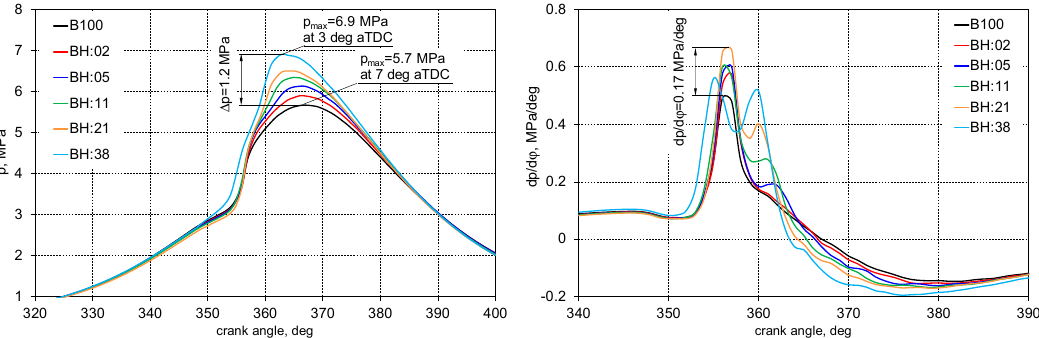
Figure 2. Combustion pressure curve and pressure rise rate for different energetic shares of hydrogen.